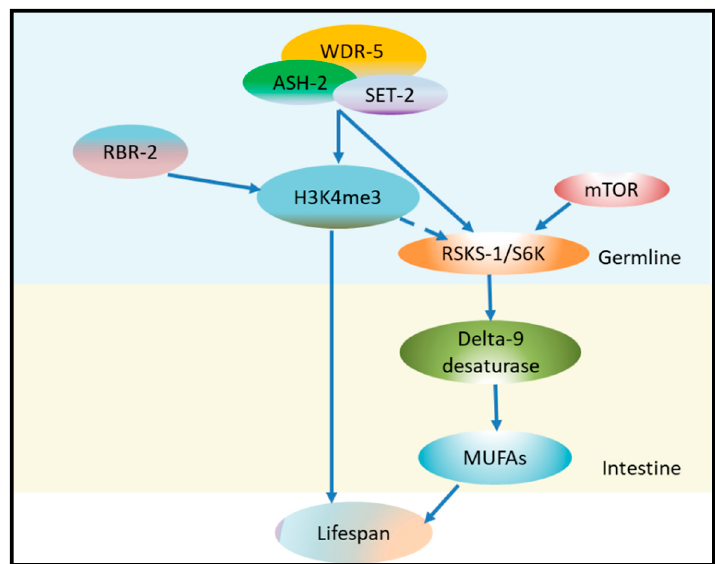
Figure 3. H3K4me3 regulates worm lifespan in a germline-dependent manner. RBR-2 demethylates H3K4me3, and the mutant of RBR-2 promotes the level of H3K4me3 and decreases lifespan. WDR-5, ASH-2 and SET-2 are the H3K4 methyltransferase complex, and the mutant in each one of them can diminish H3K4me3 level and prolong lifespan. The complex also directly or indirectly (dotted line) targets RSKS-1 / S6K (a key conserved substrate of mTOR complex 1), which upregulates the delta-9 desaturase in the intestine, leading to mono-unsaturated fatty acid (MUFA) accumulation and extension of